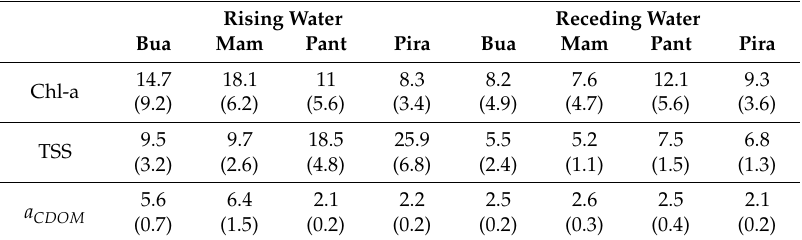
Table 1. Limnological dataset for each lake and flooding phase. The names refer to the four lakes (Bua-Bu á , Mamirau á , Pantale ã o, and Pirarara). The mean value is shown followed by the standard deviation in parenthesis. Chl-a is Chlorophyll-a in µ g/L, TSS is in mg/L, and a CDOM is a CDOM ( 420 ) in m − 1